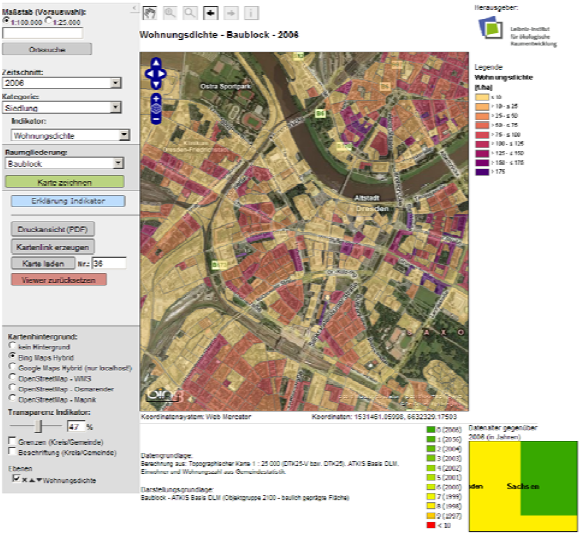
Figure 4. View of the indicator’s block-based building surface area in the detail viewer for the city of Dresden